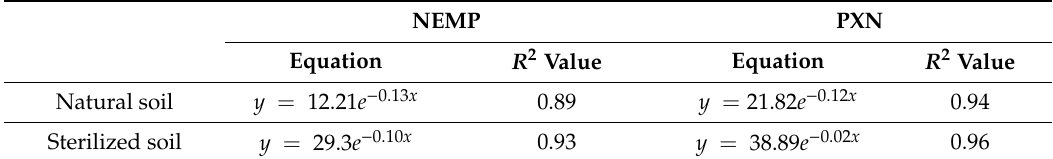
Table 9. Half-life for NEMP and PXN.